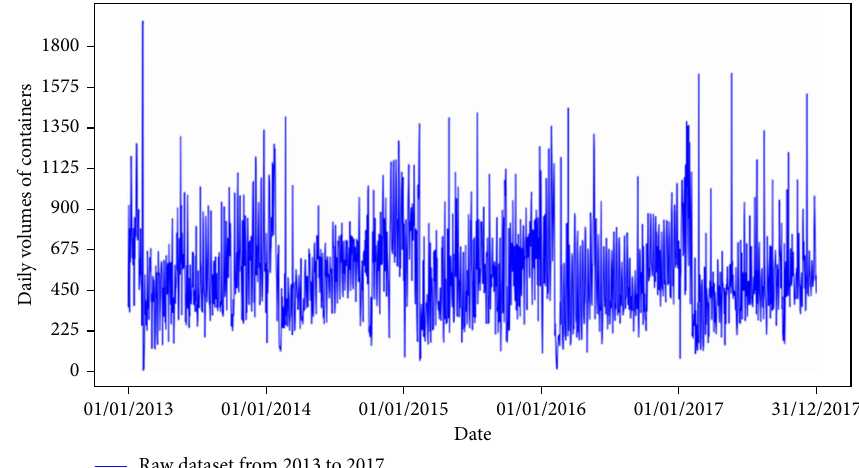
Figure 2: The raw dataset of daily container volumes from 2013 to 2017.